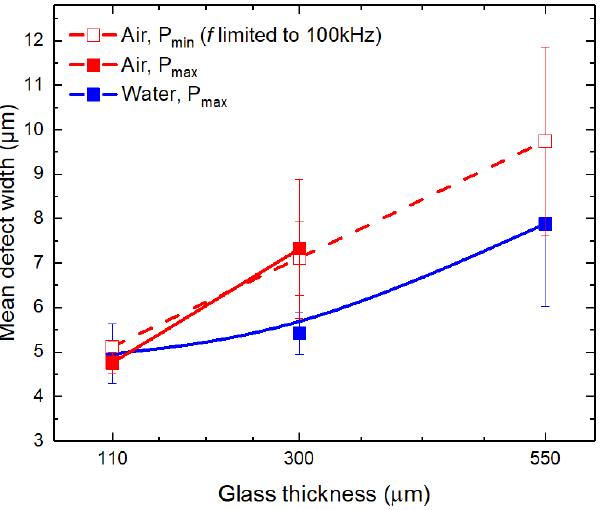
Figure 5. Mean defect widths at the cut edge at the front side of laser-cut glass strips. Dots are connected to guide the eye. Error bars indicate standard deviation.